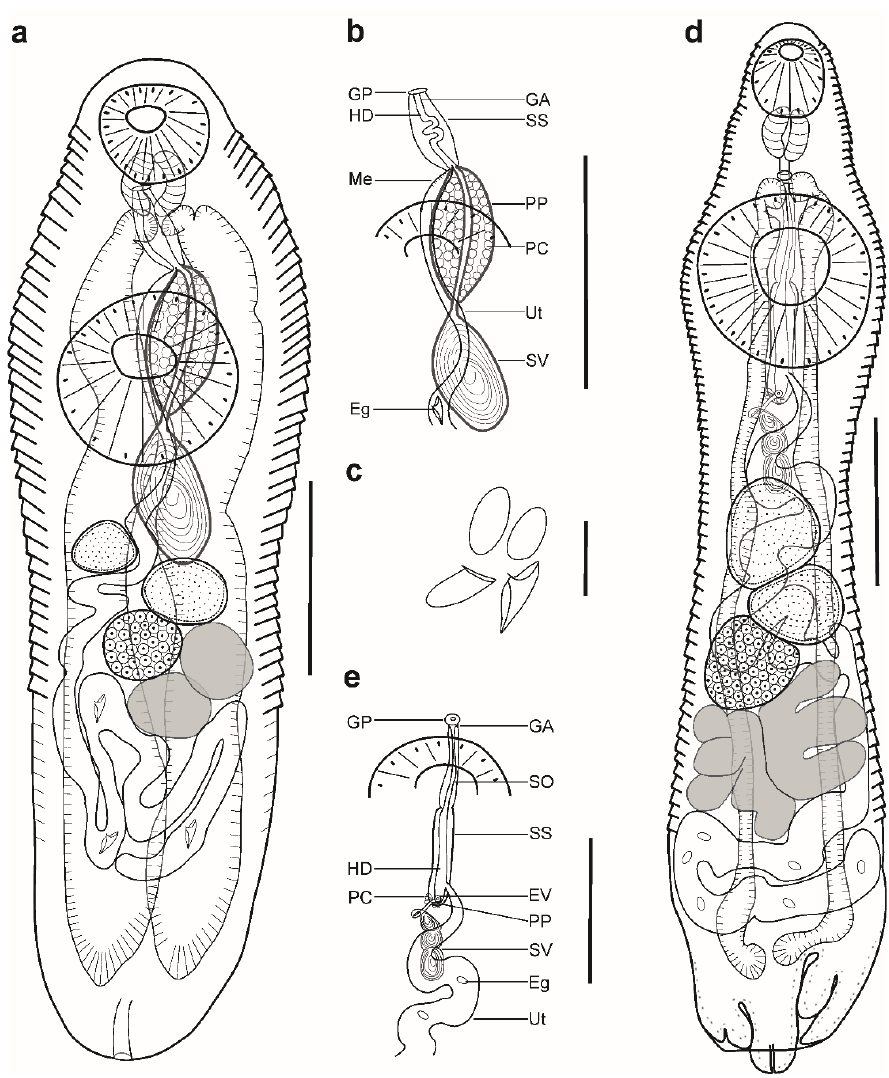
Figure 1. Hemiurid parasites of marine fishes from Brazil. ( a – c ) Adult of Myosaccium ecaude ex Harengula clupeola : ( a ) complete specimen, ventral view; ( b ) detail of the terminal genitalia, ventral view; ( c ) eggs; ( d – e ) adult of Ectenurus virgula ex Decapterus puntatus : ( d ) complete specimen, ventral view; ( e ) detail of the terminal genitalia, ventral view. Scale bars ( a – b , d – e ): 200 μm; ( c ): 50 μm. Abbreviations : Eg, eggs; GA, genital atrium; GP, genital pore; HD, hermaphroditic duct; PC, prostatic cells; PP, pars prostatica; SO, sinus-organ; SS, sinus-sac; SV, seminal vesicle; Ut, uterus.